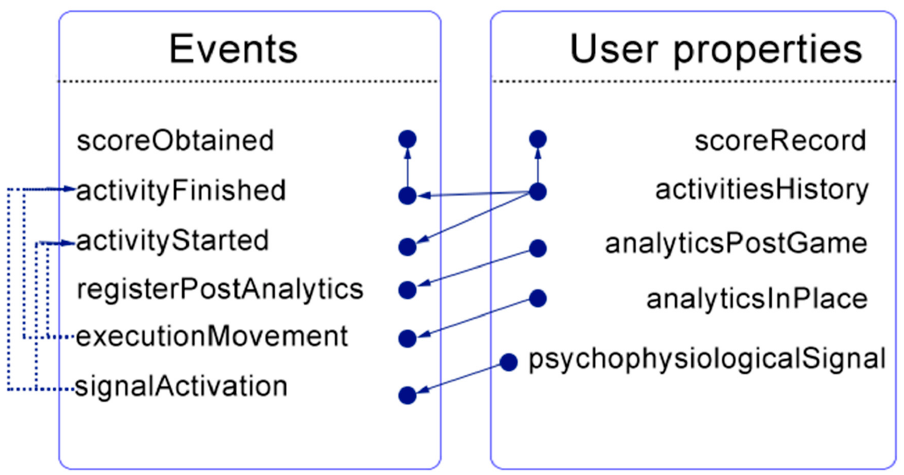
Figure 2. Events-user properties logical link for the adaptation component (AC) formal definition.